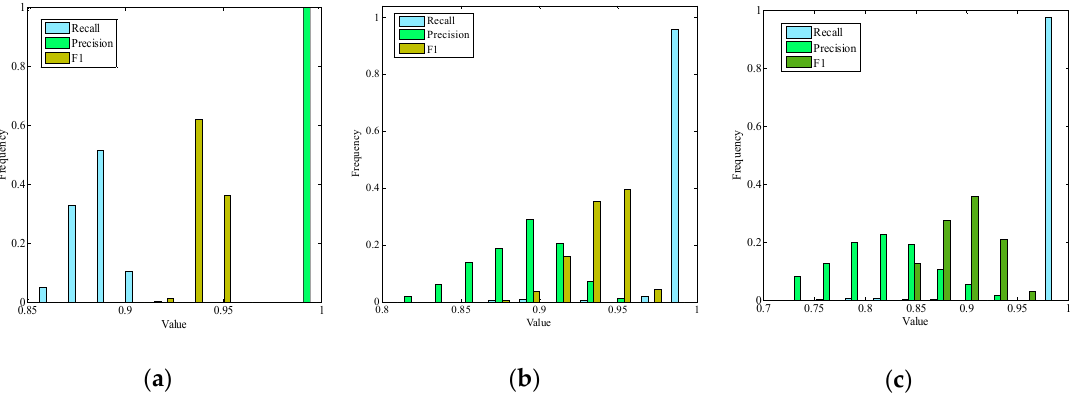
Figure 7. Generating density-connected repulsive clusters. ( a ) All points in this set have been identified as repulsive points and generated as a single repulsive cluster. ( b ) Three repulsive clusters have been identified, including cross, square and circle clusters. ( c ) Two repulsive clusters have been identified, including cross and square clusters.